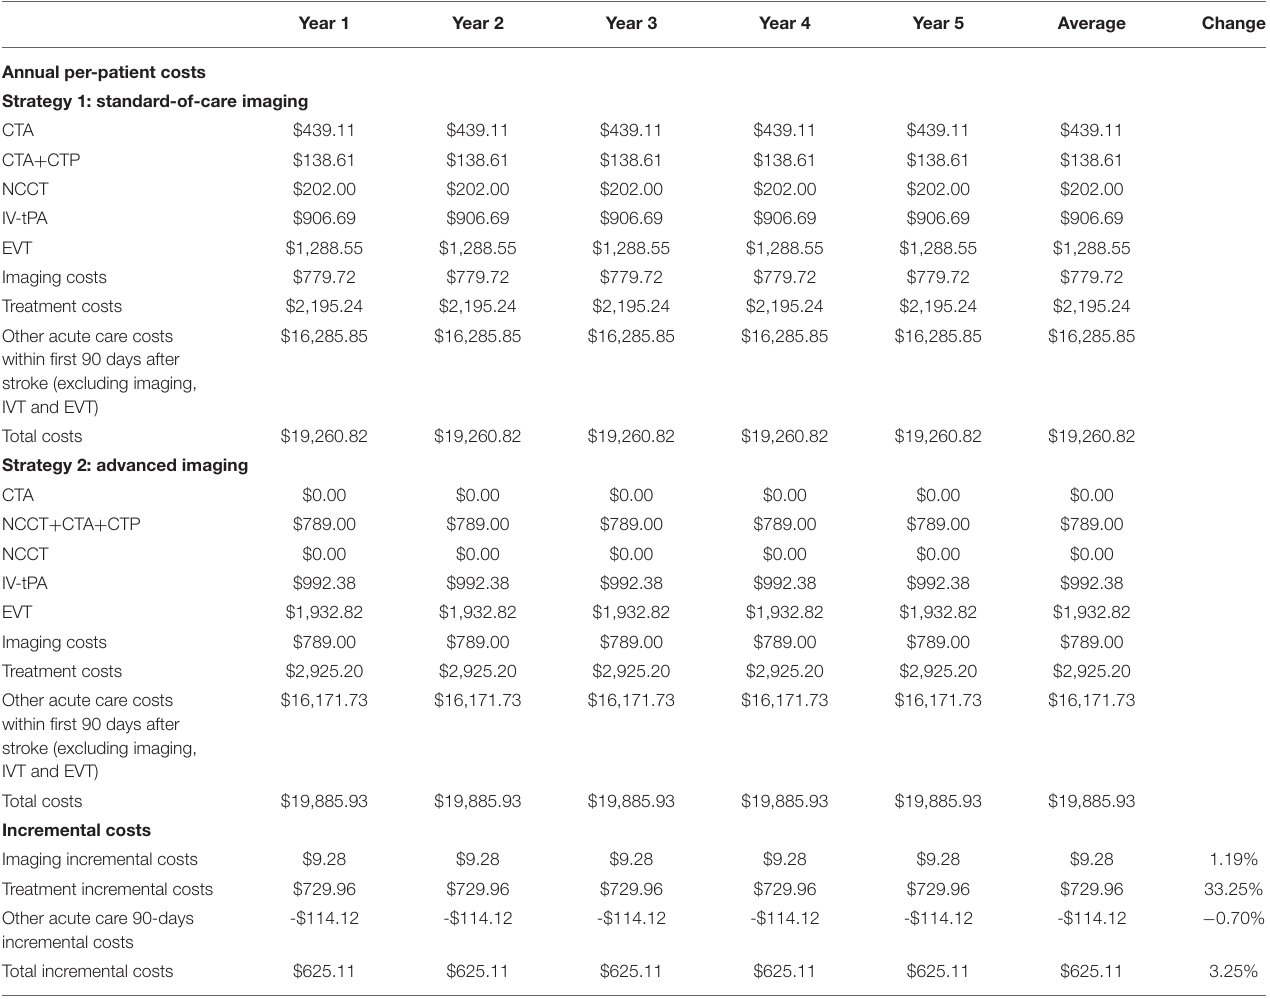
TABLE 3 | Per-patient costs projection for the 5-year period for the standard-of-care and advanced CTAP imaging